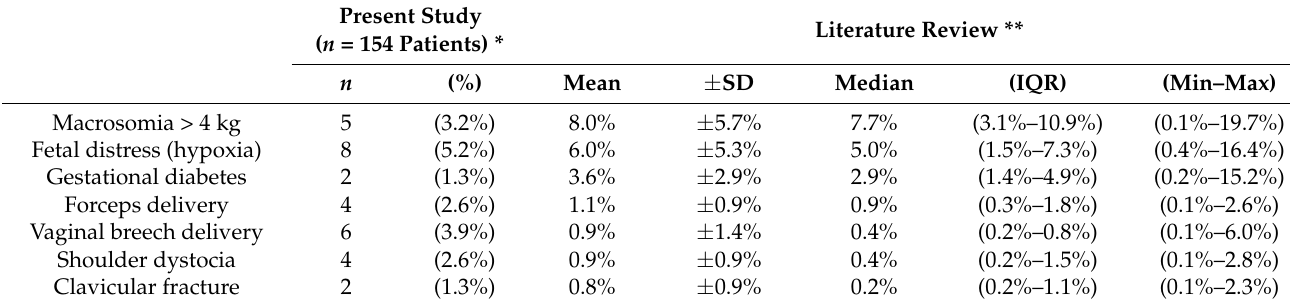
Table 1. Perinatal risk factors for OBPP.